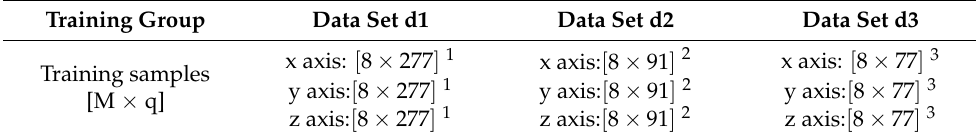
Table 3. Training